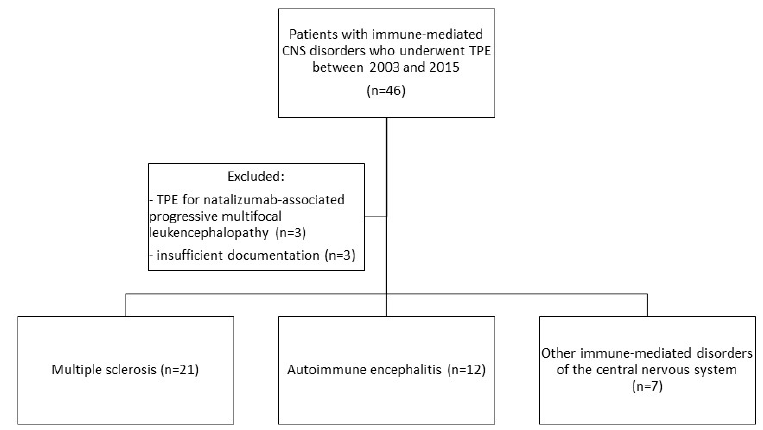
Figure 1. Flow chart for patient selection.